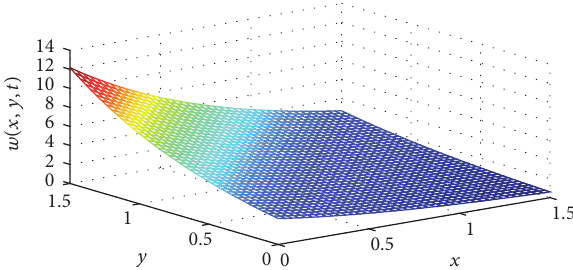
Figure 3: Behavior of 𝑤 of initial value system (12) in (0, 1.5) .